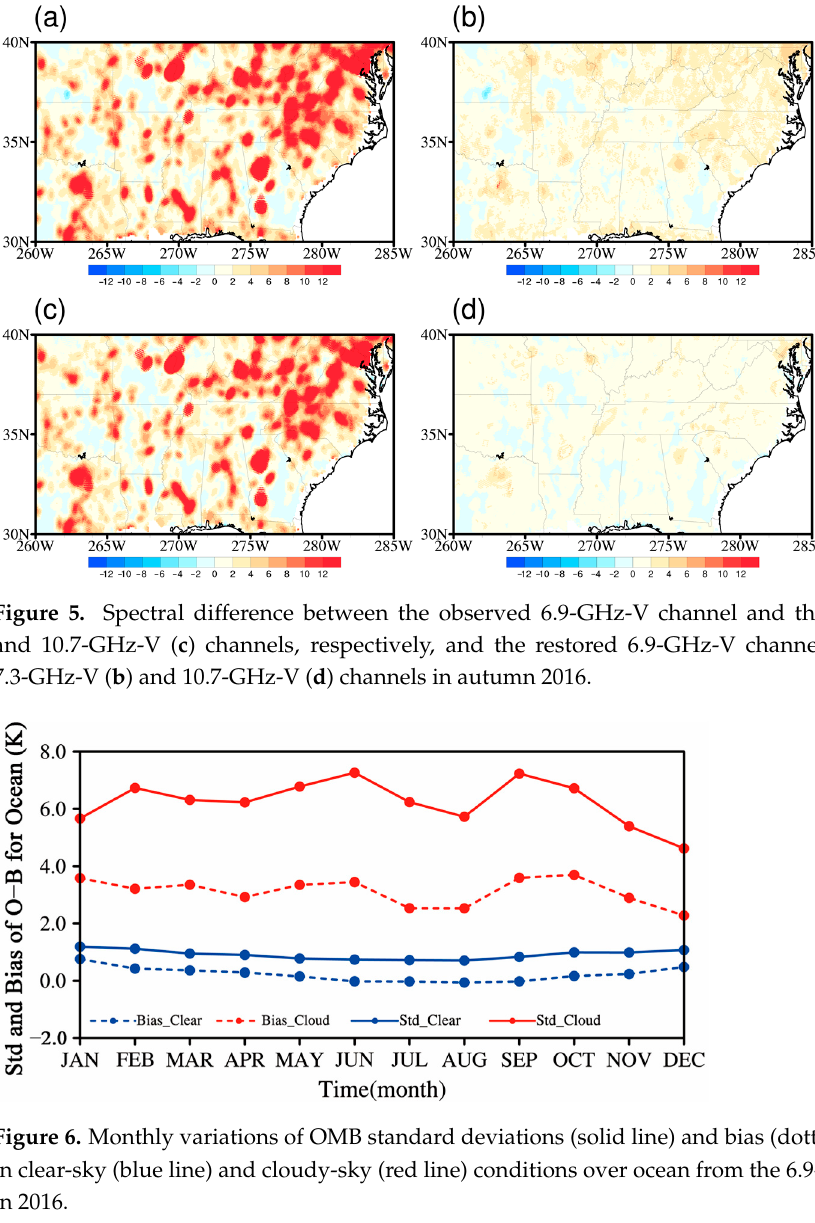
Figure 7. Averaged OMB before ( a ) and after ( b ) the restoration for the 6.9-GHz-V channel in au- tumn 2016. Although it is clear that the spatial continuity of the brightness temperature data was improved through the restoration process, the impact of this restoration method on the standard deviations still needs to be further clarified in order to apply this method in data assimilation. Figure 8 shows the standard deviation and mean values of the OMB before (magenta line) and after the restoration (red line) for RFI-affected data of the 6.9-GHz-V channel. For comparison, the undisturbed data (blue line) are also shown here. The pink and gray bars in Figure 8a represent the numbers of RFI-affected and RFI-free pixels,